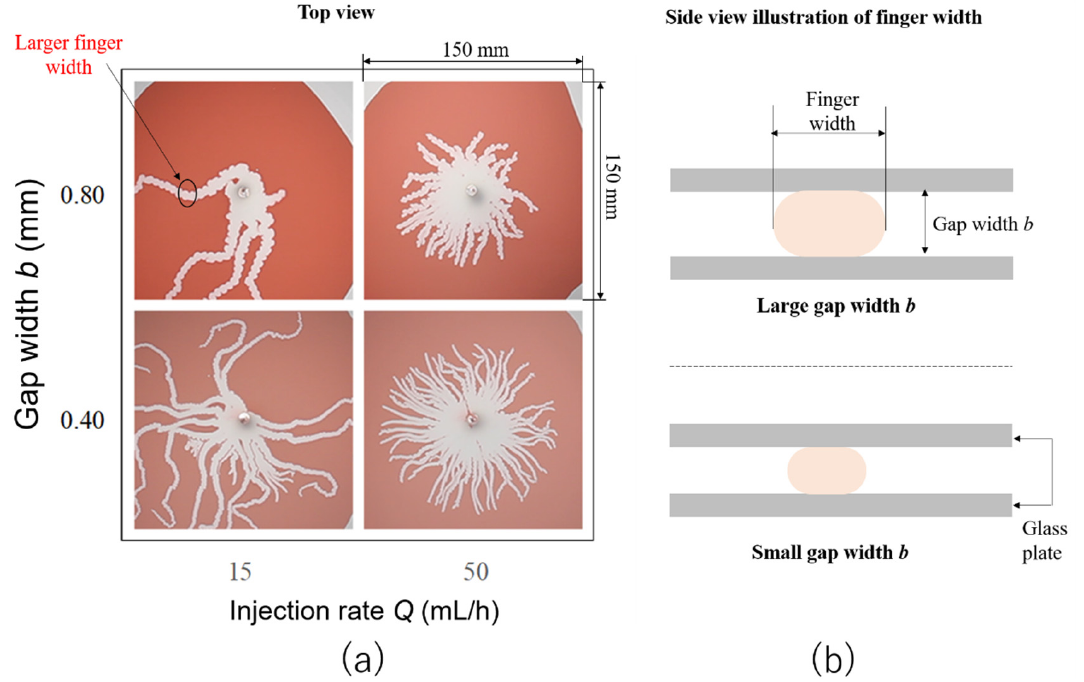
Figure 5. ( a ) Top view of displacement patterns when the gap widths are 0.4 and 0.8 mm and injection rates were varied from 15 to 50 mL/h. The volume of the injected aqueous citric acid solution is 2 mL. ( b ) Side view illustration of how the finger width changes with gap width b . The sphere-like shape represents the aqueous citric acid solution.